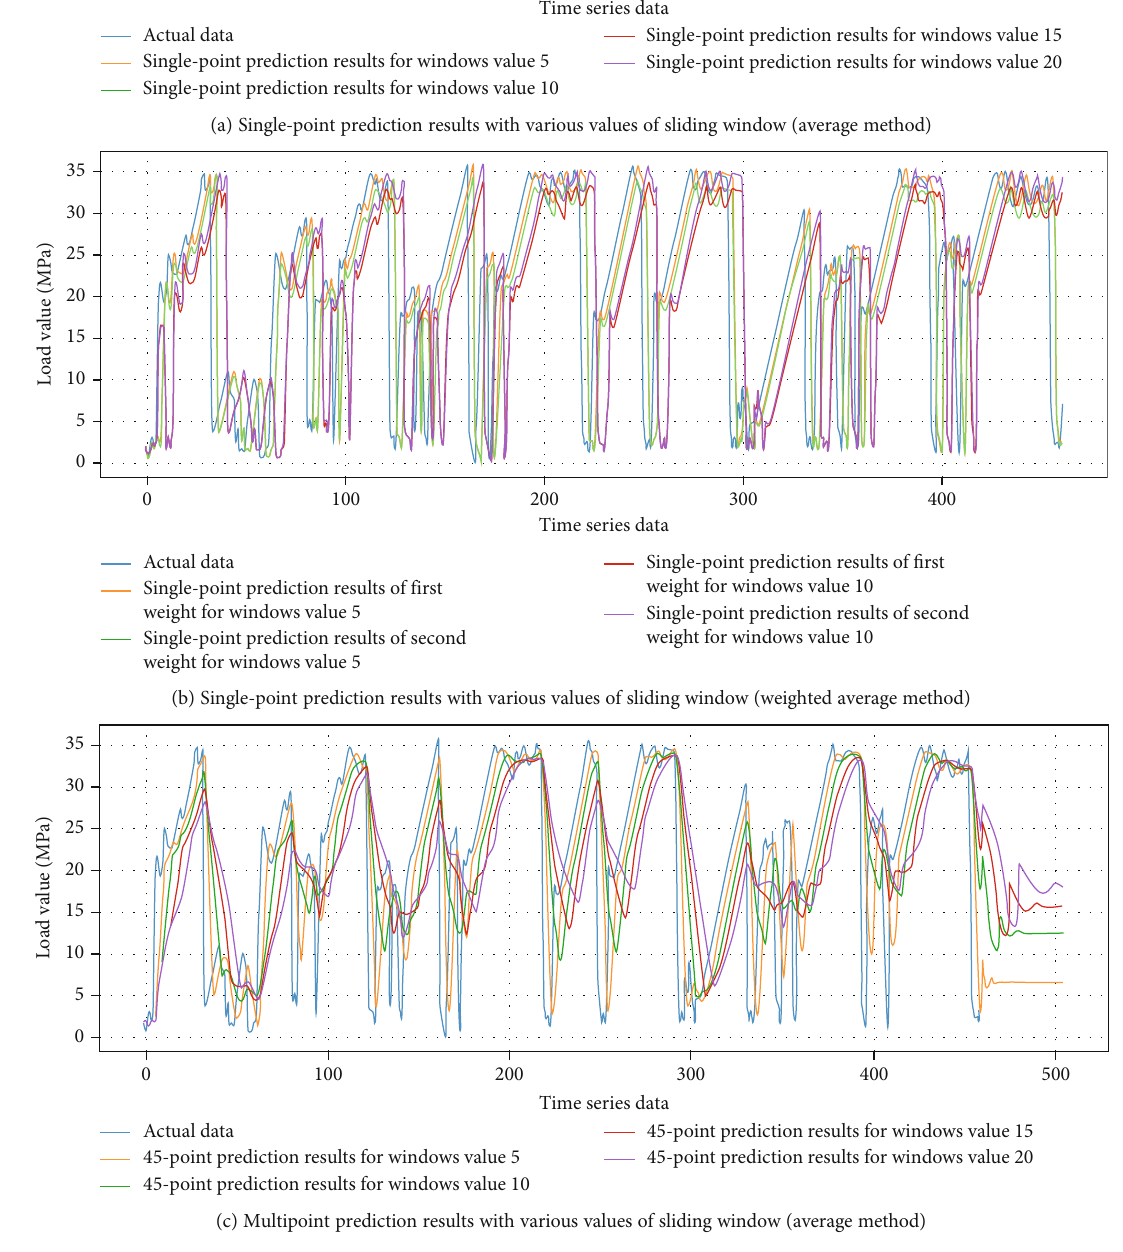
Figure 3: Load prediction e ff ect of hydraulic support based on the sliding window